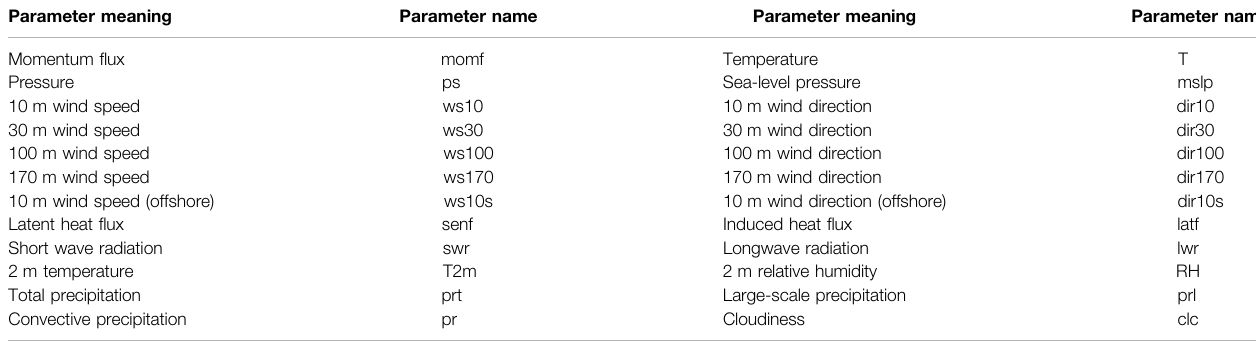
TABLE 1 | NWP parameter meaning and name for one wind